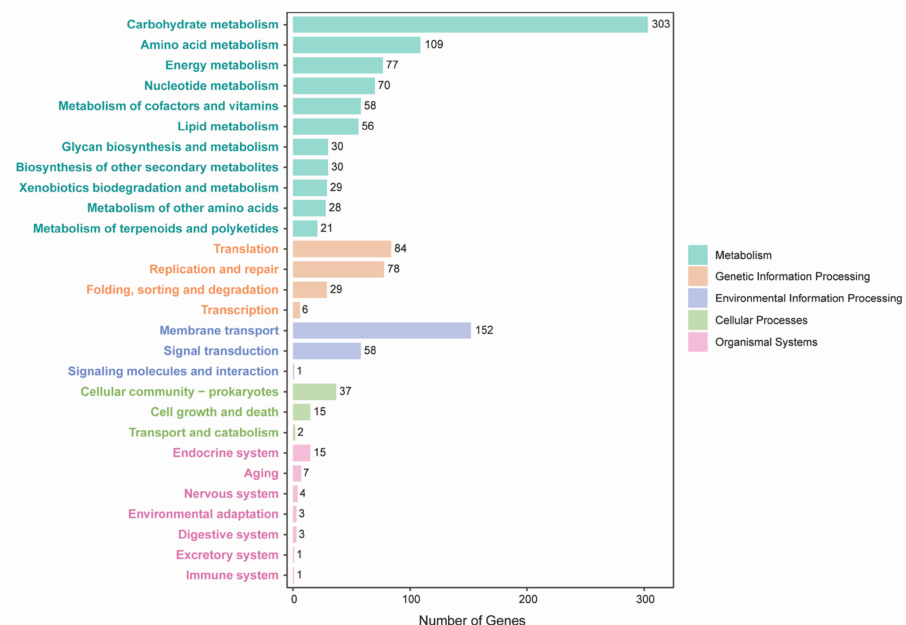
Figure 3. KEGG annotation of E. faecium H7 strain. KEGG functions are distributed in different categories. Bars of each functional term indicate the coding gene number for